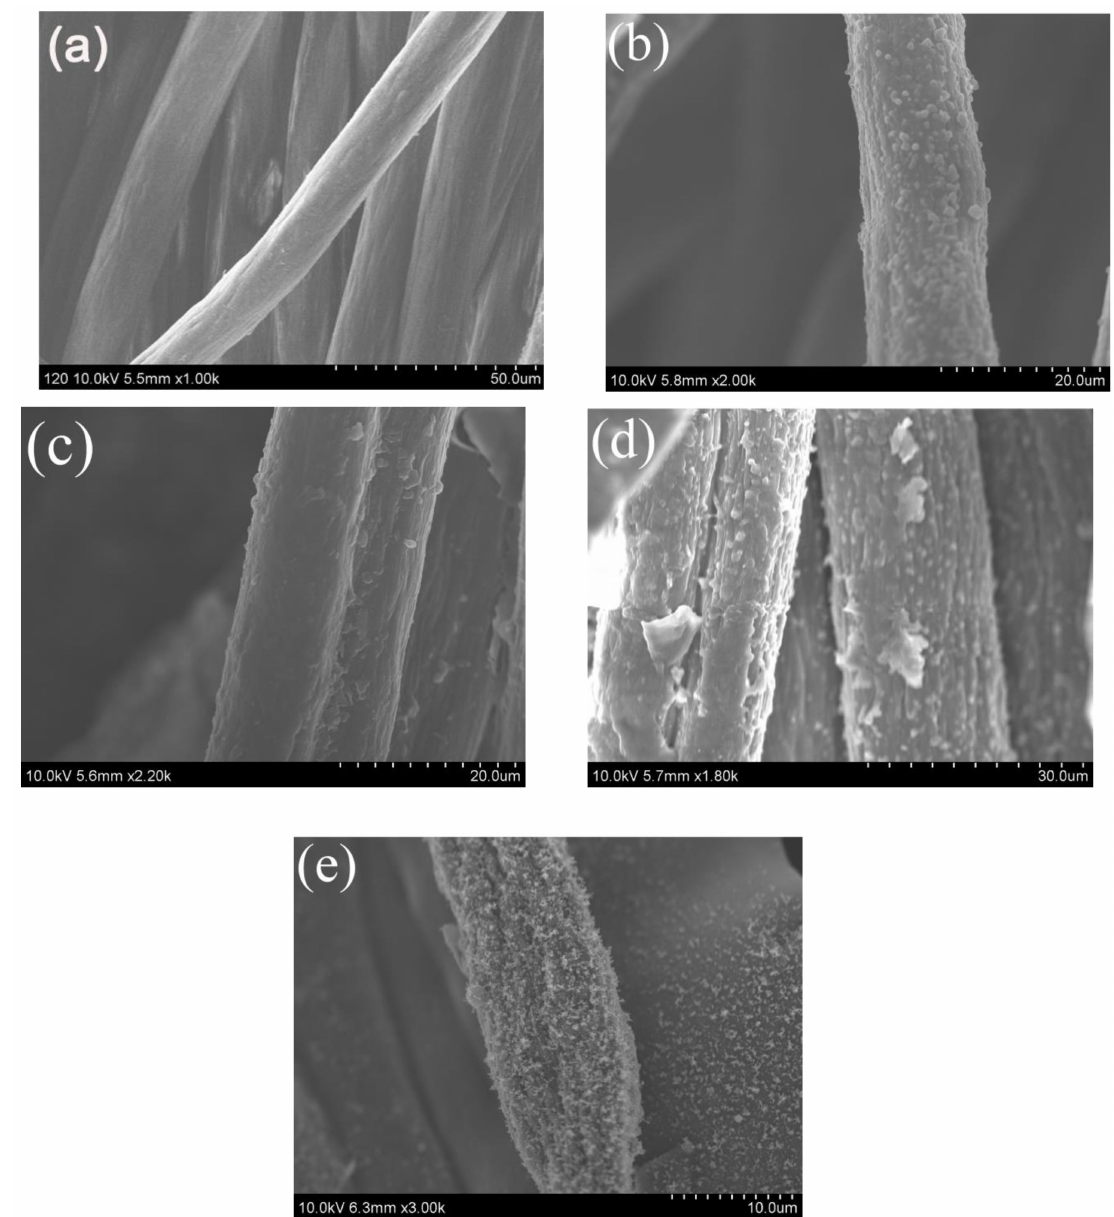
Figure 7. SEM photos of ( a ) PAN; ( b ) PAN-g-GMA; ( c ) PAN-g-GMA-g-CS; ( d ) FR-PAN; ( e ) char residue of